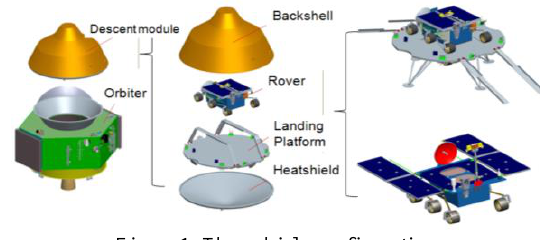
Figure 1. The vehicle